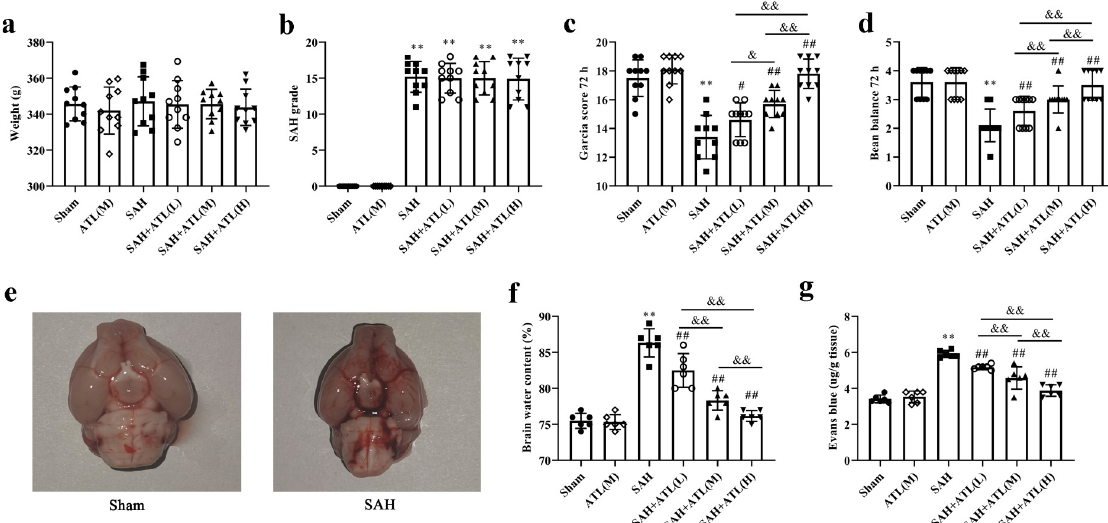
Fig 1. Effects of ATL on neurologic deficits, brain edema and BBB disruption at 72h after SAH. The Weight (a), SAH grade (b), Garcia score (c), beam balance (d), the whole brain (e), brain water content (f), EB extravasation (g) among each group. Data are represented as the mean ± SD. �� p < 0.01 vs. sham group; # p < 0.05 and ## p < 0.01 vs. SAH group; & p < 0.05 and && p < 0.05. a-d, n = 10, the number of animals; f and g, n = 6, the number of